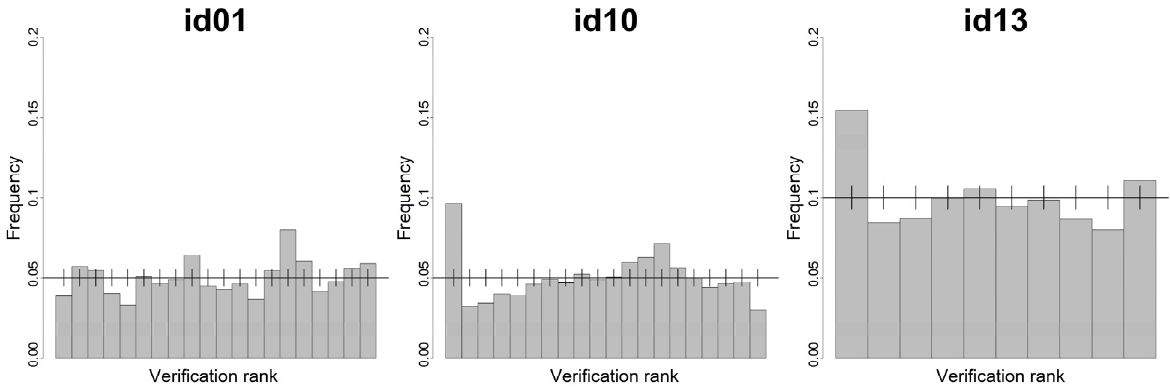
Figure 11. Rank histograms of the 0–72 h ahead probabilistic wind power forecasts starting at 12 UTC for the Abruzzo test case.